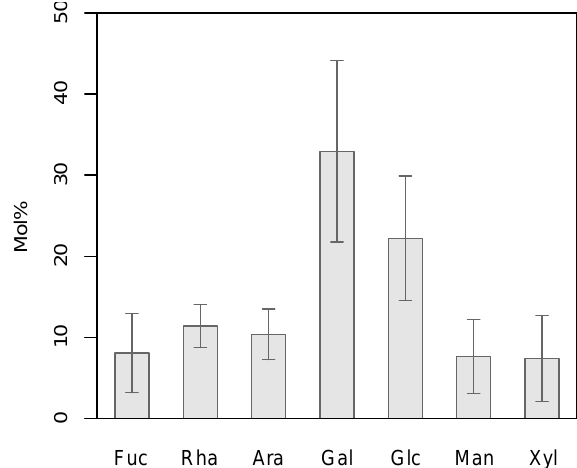
Figure 5. Molecular composition of neutral sugars produced by bacteria. Mean and standard deviations were calculated from the four glucose-enriched samples ( n = 4). The mean and standard de- viations of data from the study by Ogawa et al. (2001) were calcu- lated from duplicate measurements of bacterially produced neutral sugars sampled on days 4 and 7 ( n = 4).